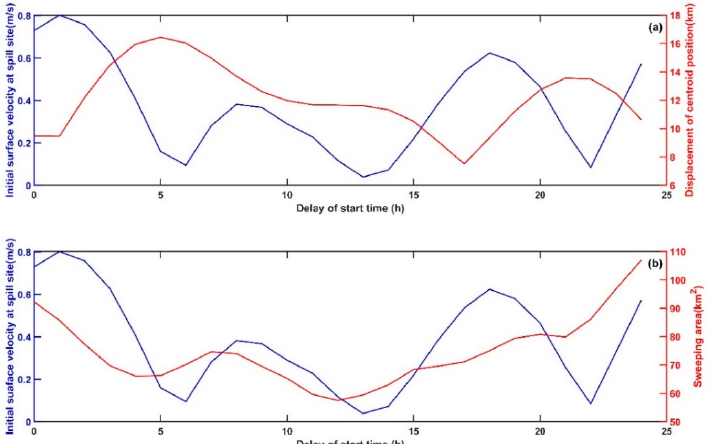
Figure 13. ( a ) The maximum displacement of the oil spill at the sea surface (red line) and the initial surface velocity at the location of oil spill site (blue line) in SE3. ( b ) The maximum sweeping area of the oil spill at the sea surface (red line) and the initial surface velocity at the location of oil spill site